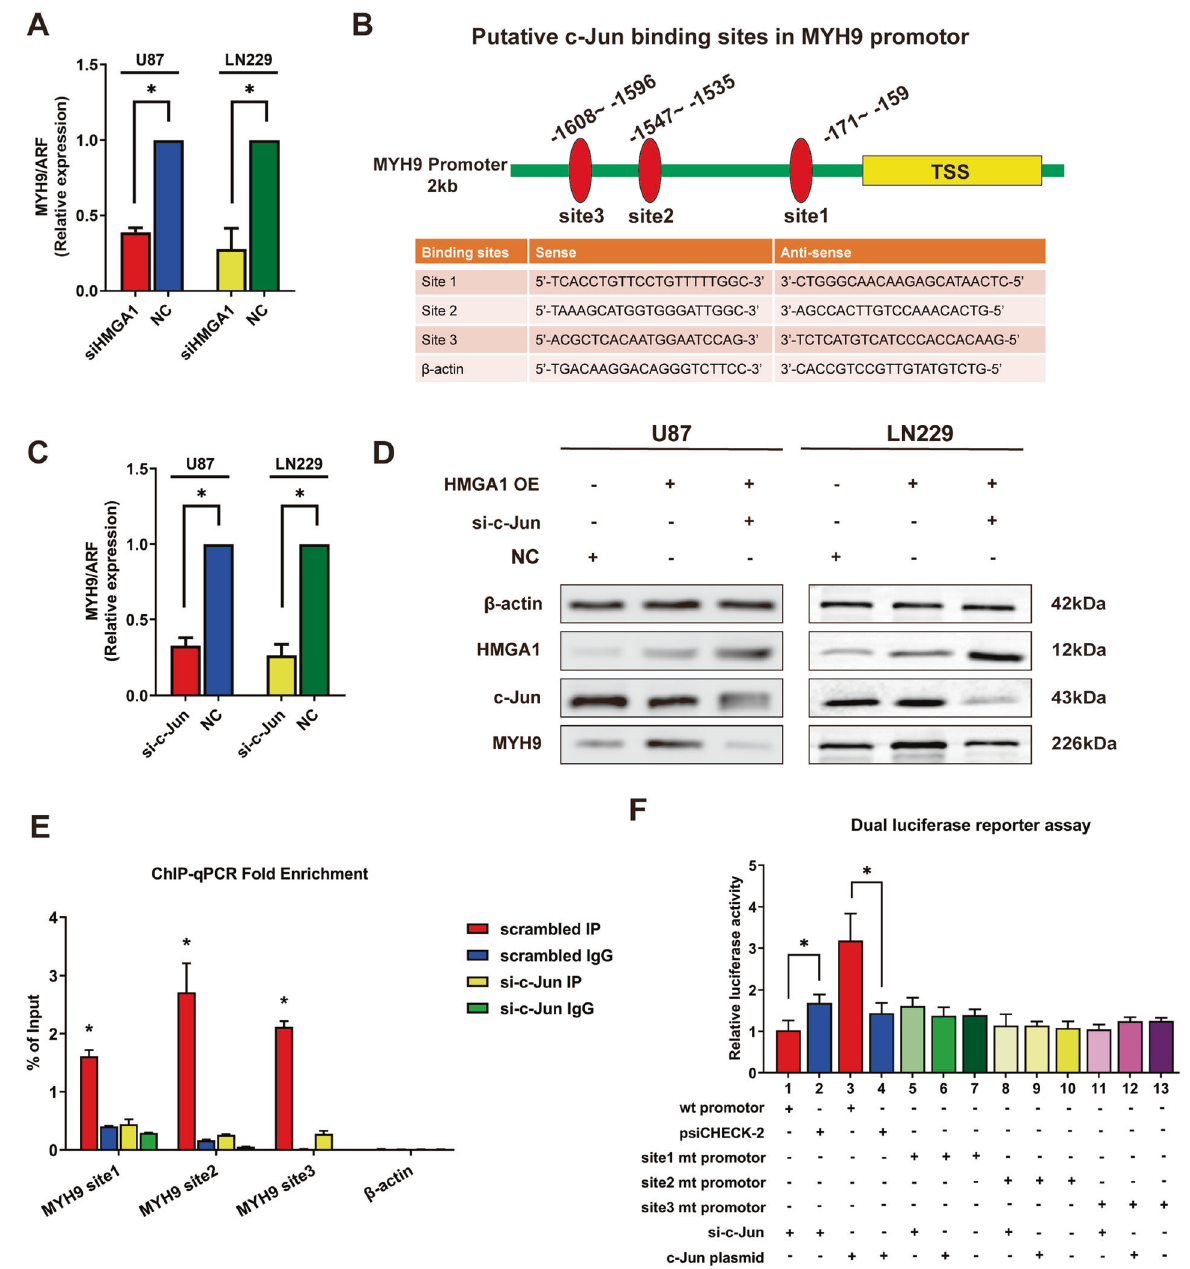
Fig. 2 HMGA1 increased the expression of MYH9 through c-Jun-mediated transcription. A Knockdown HMGA1 leads to the decreasing of MYH9 mRNA expression. B Schematic diagram of putative c-Jun binding sites in MYH9 promotor and the primers of each binding site. C , D Knockdown c-Jun induced inhibition of MYH9 mRNA ( C ) and protein ( D ) expression. E c-Jun bound to all the predicted sites inside the transcription regulatory region of MYH9, and knockdown of c-Jun could inhibit the protein – DNA interactions in all three binding sites. F Dual- luciferase reporter assay showed that the reporter plasmid with the promotor region of MYH9 resulted in a signi fi cant decrease in luciferase activity after transfection with si-c-Jun, whereas the plasmid without MYH9 promotor had no change in luciferase